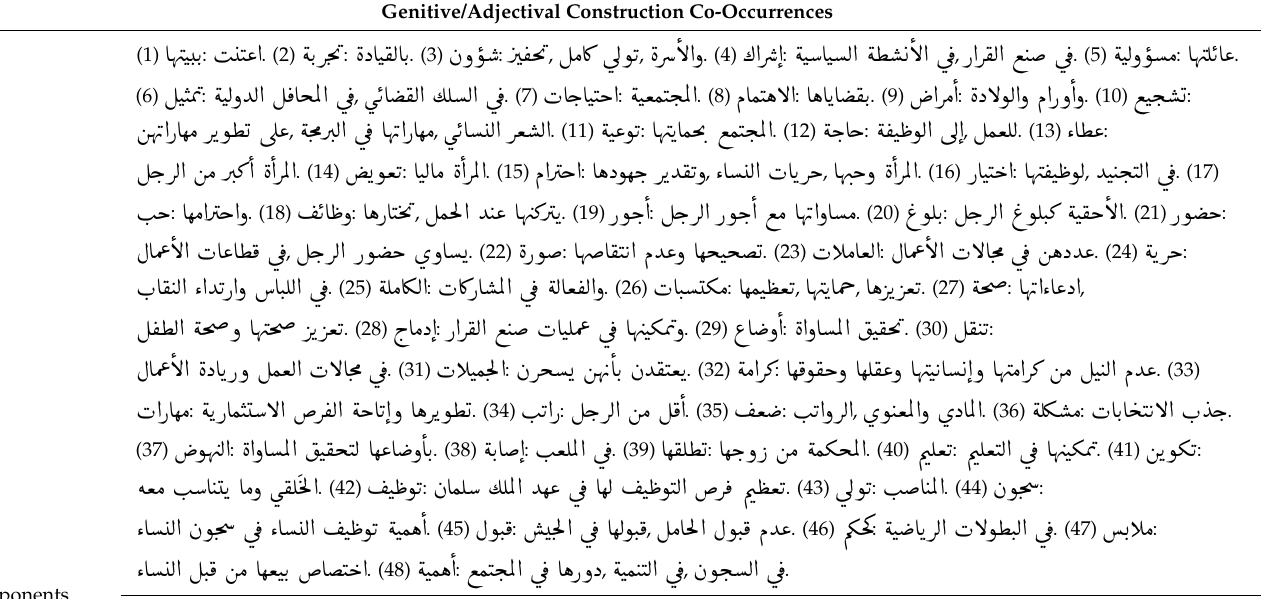
Table 14. Broad contexts of the genitive/adjectival construction co-occurrences (nf = <0.00001 × 100). Genitive/Adjectival Construction